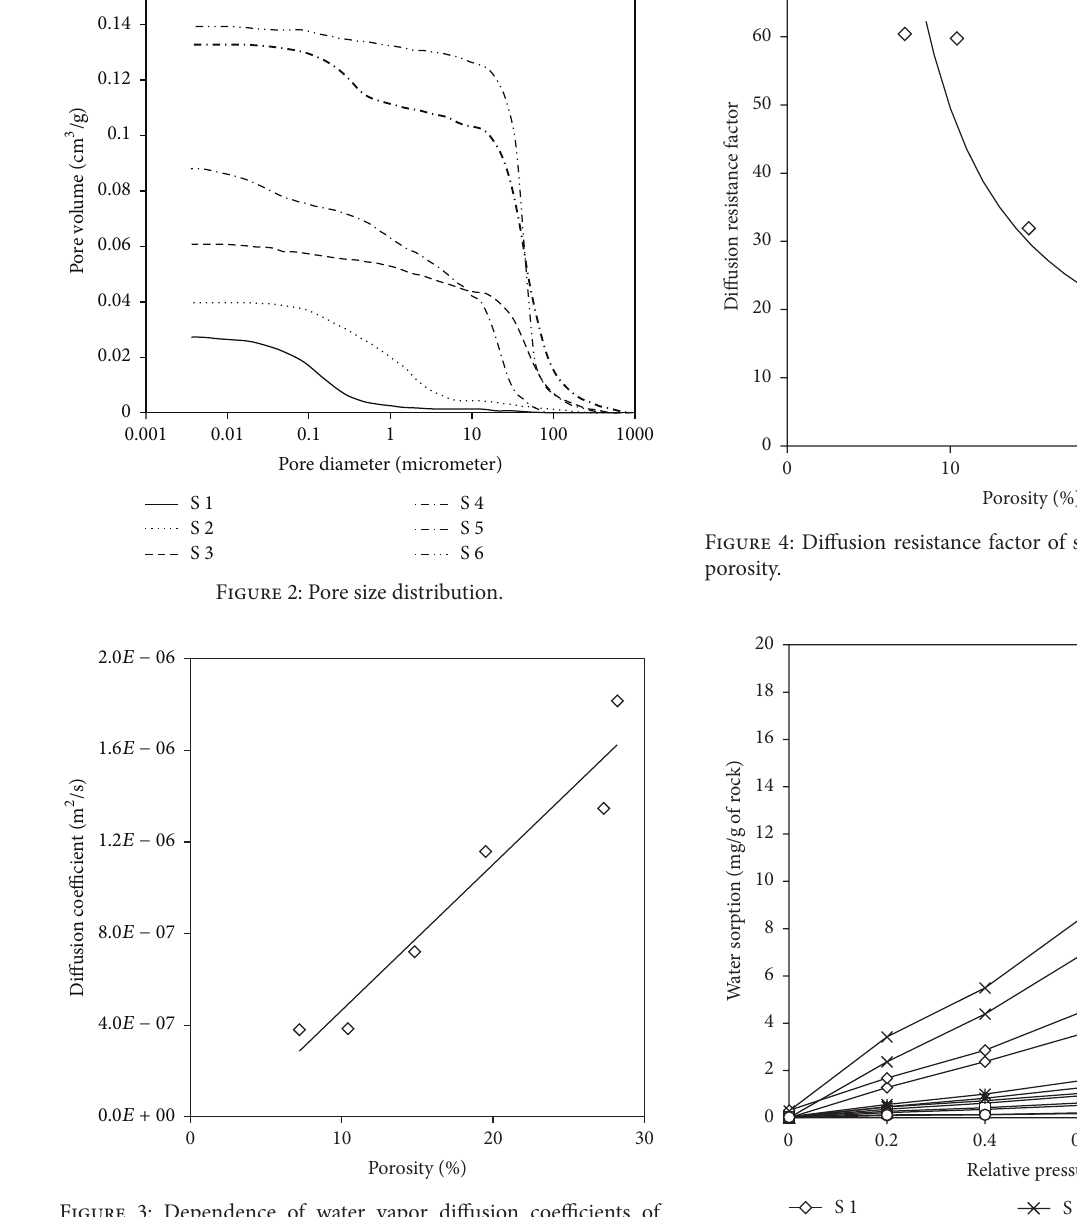
Figure 3: Dependence of water vapor diffusion coefficients of sandstones on porosity.